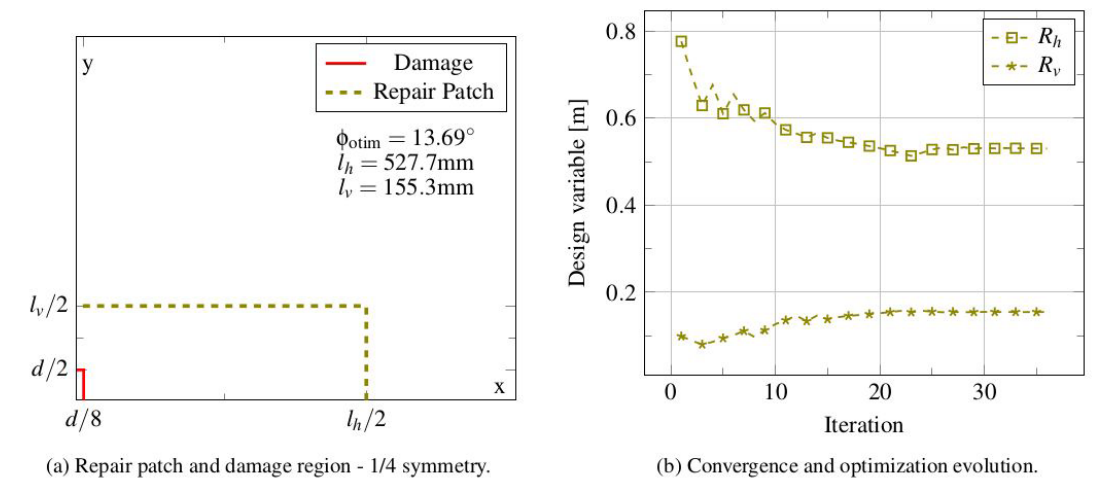
Figure 8. Rectangular repair patch - SS with an unsymmetrical stacking